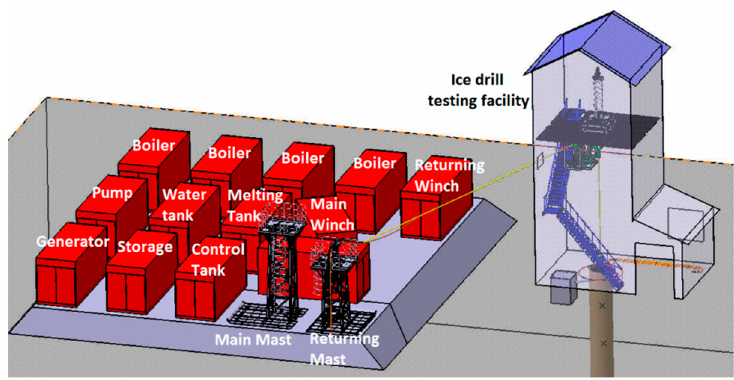
Figure 1. Schematic diagram of the overall hot water drilling system.